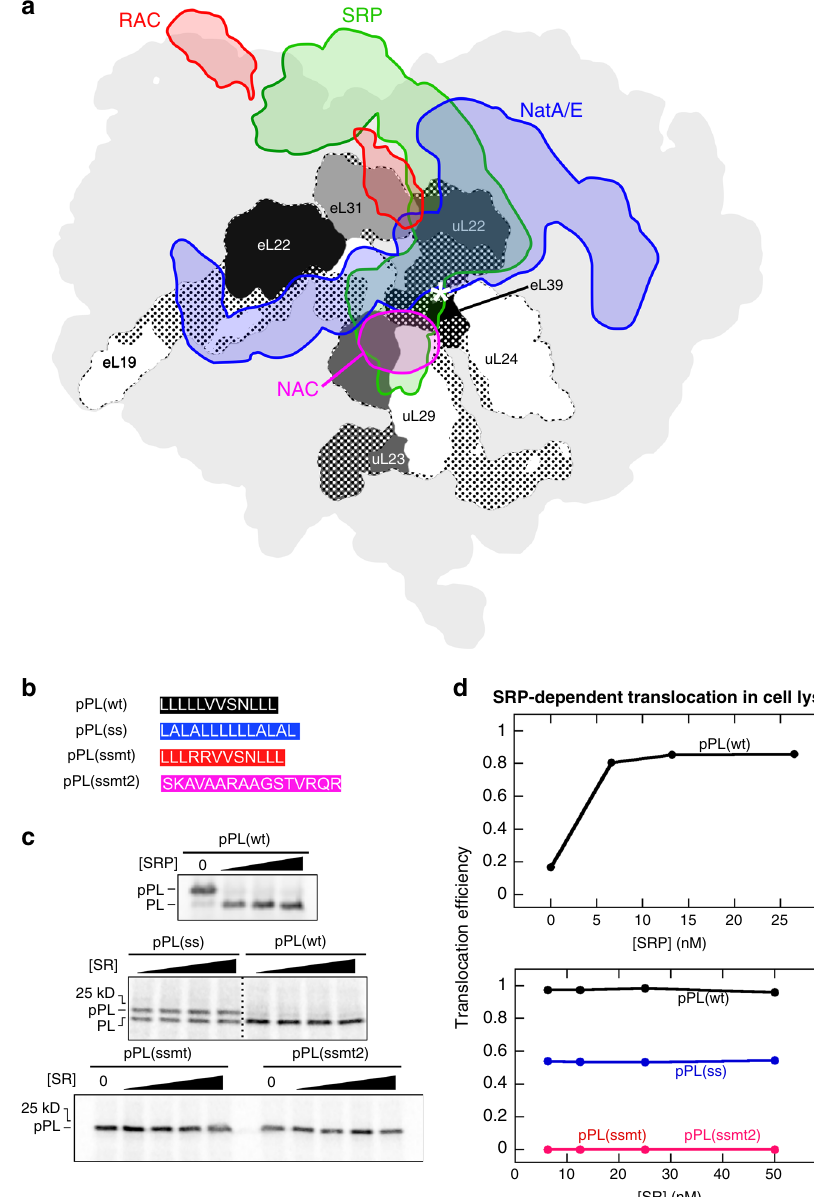
Fig. 1 Selective protein targeting by SRP in translation lysate. a Projections of the EM densities of structurally resolved RPBs onto the surface of the 80S ribosome (PDB: 4UG0; light gray) 78 viewed from the tunnel exit (marked by an asterisk). The electron density map of the RPBs (SRP: EMD-3037 6 , green; NAC: EMD-4938 23 , magenta; RAC: EMD-6105 79 , red; and NatA/E: EMD-0202 80 , blue) were overlayed using the structure of 80S in Chimera (UCSF). The densities of ribosomal proteins surrounding the tunnel exit are shown in different shades of gray, with dotted areas indicating the parts buried underneath the ribosomal surface. Due to the limited resolutions of the original EM maps, the projections of NAC and RAC are likely incomplete. b Composition of the signal sequence variants tested in this work. c Translocation assay showing the speci fi c targeting of pPL(wt) and pPL(ss). SRP-dependent cotranslational protein translocation were measured for the indicated nascent proteins as described in the Methods section and analyzed by SDS-PAGE and autoradiography. The bands for preprolactin (pPL) and signal sequence-cleaved prolactin (PL) are indicated. d Quanti fi cation of the data in c . The values for pPL(ssmt) and pPL(ssmt2) are very close and overlap with each other in the fi gure. Translocation ef fi ciency was calculated using Eq. (3) in the Methods section. Source data for c and d are provided in the Source Data fi